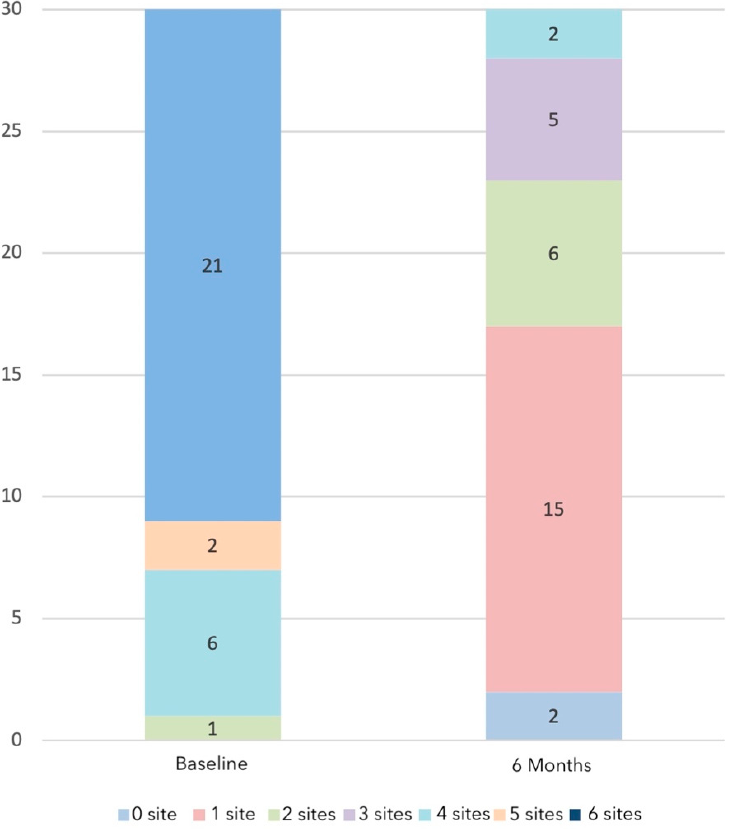
Figure 3. Distribution of the number of implant sites with bleeding on probing at baseline and 6 months.